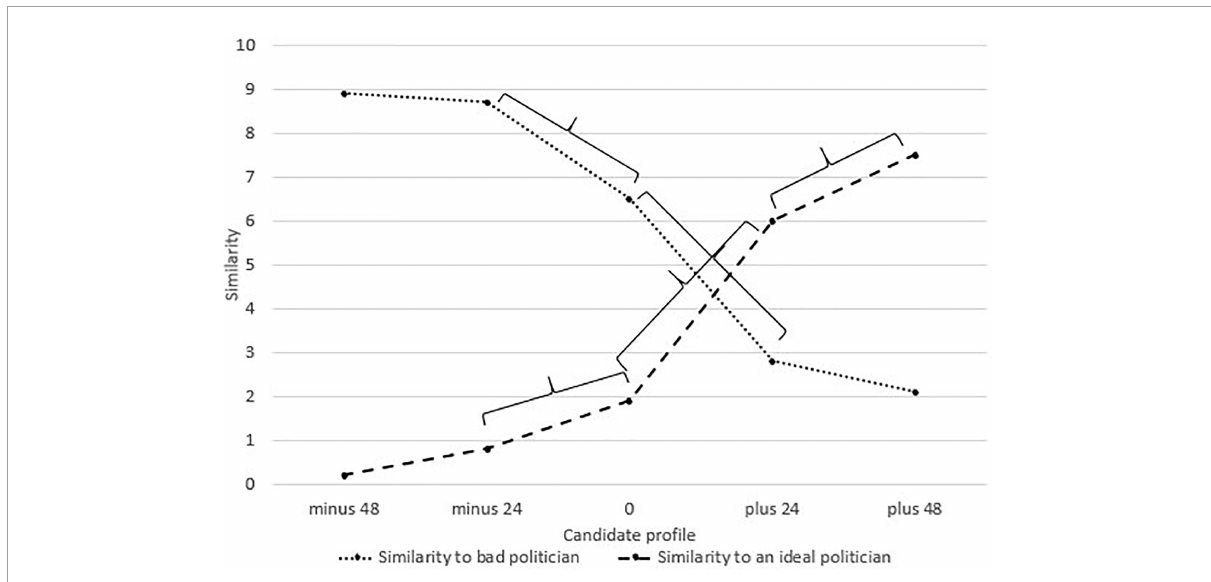
FIGURE1 Means of the similarity to an ideal and bad politician for candidates analyzed in study 1. Captions minus 48, minus 24, 0, plus 24, and plus 48 refer to the overall valence of candidate profiles. Brackets mark significant differences ( p < 0.01) between the analyzed